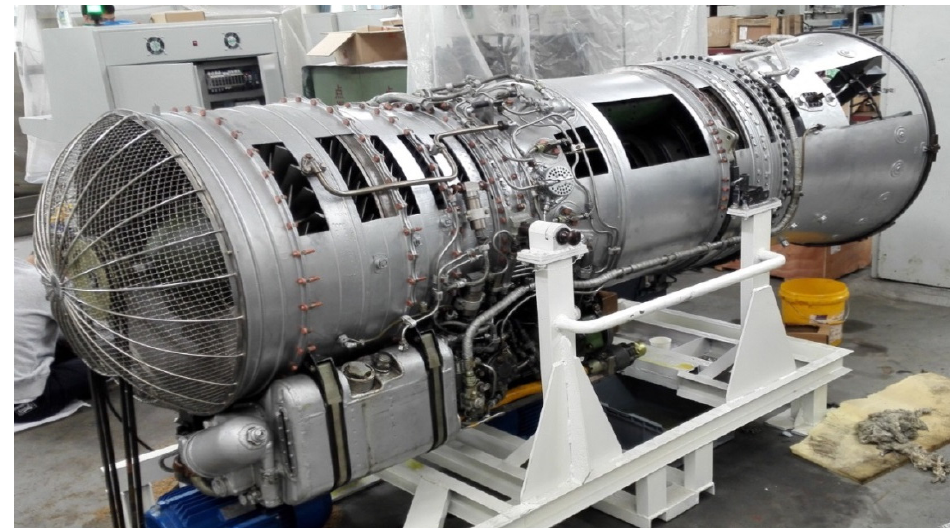
Figure 2. Prototype of an aeroengine.